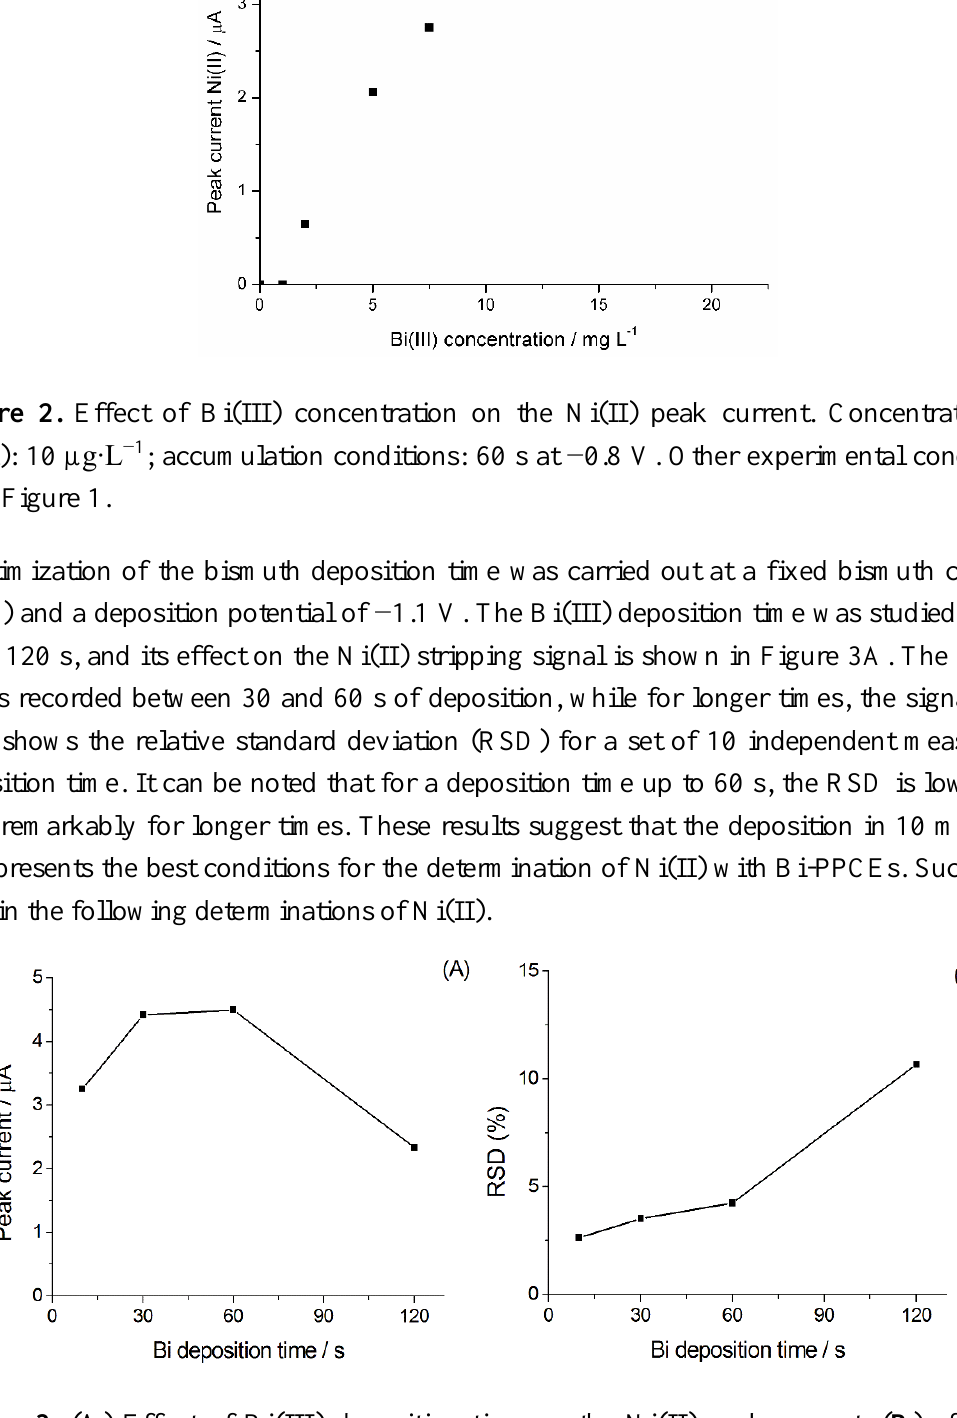
Figure 3. ( A ) Effect of Bi(III) deposition time on the Ni(II) peak current; ( B ) effect of Bi(III) deposition time on the Ni(II) peak relative standard deviation (RSD). Concentration of Ni(II): 10 µg∙L −1 , accumulation time at −0.8V 60 s. Other experimental conditions as in Figure